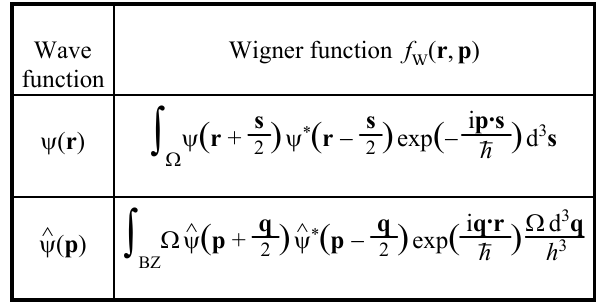
Table 2 . Definition of the Wigner function f function ψ in either the position or the momentum